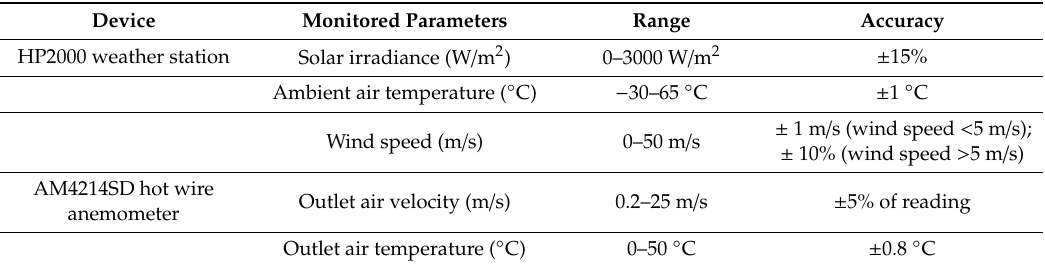
Table 2. The characteristics of the monitoring